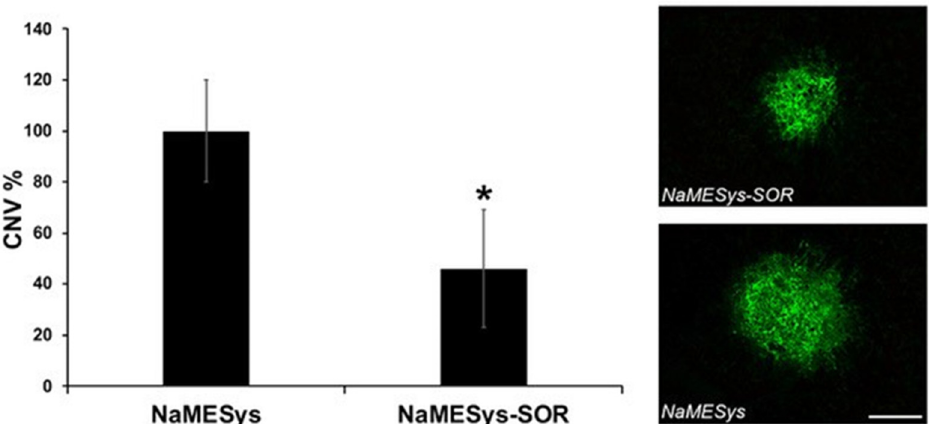
Figure 5. Nanostructured microemulsions system carrying 0.3% sorafenib (NaMESys-SOR) inhibited laser-induced choroidal neovascularization (CNV) when delivered by topical administration. CNV volumes were measured after 7 days from laser-induced damage by Isolectin B4 staining of retinal pigment epithelium (RPE)-choroid flat mounts. n = 5 mice per group. The following number of spots were analyzed: NaMESys = 14, NaMESys-SOR = 20. Data are presented as the mean ± SEM. * p = 0.0135 vs. vehicle (NaMESys). On the right, representative pictures of CNV. Scale bar: 100 µm.